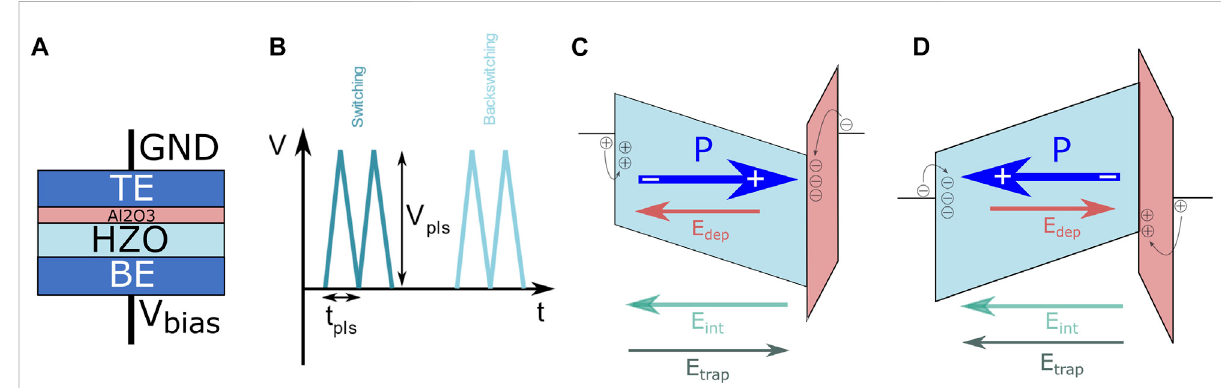
FIGURE 2 (A) Stack schematic of a HZO/Al 2 O 3 bilayer with the ground and bias indicated; (B) appliedvoltages as afunction of time, indicating pulse width (varied in our experiments) and height; band diagrams of the HZO/Al 2 O 3 device stack in the (C) P up state (positive polarity) and (D) P down state (negative